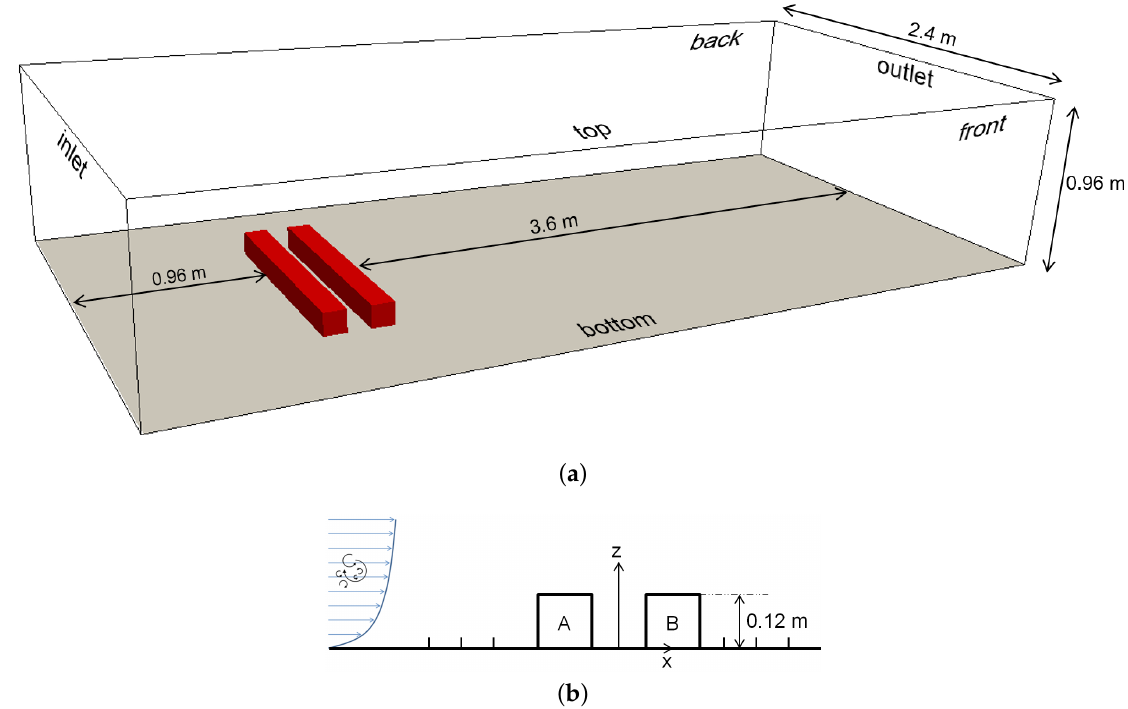
Figure 2. Geometry for flow field validation. ( a ) Overview of the computational domain. ( b ) Detailed view on the cross section of the two buildings forming a street